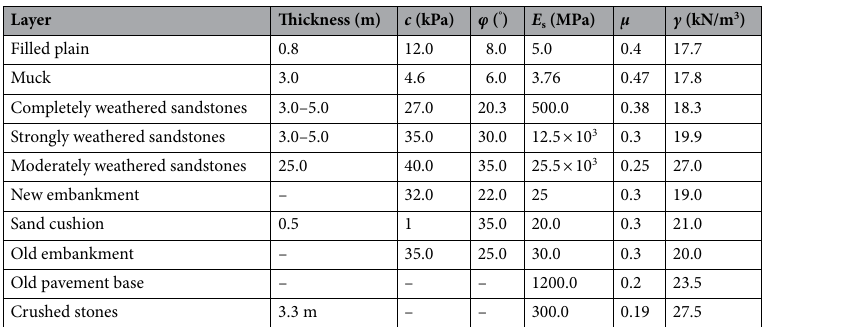
Figure 5. Layout of the numerical model.